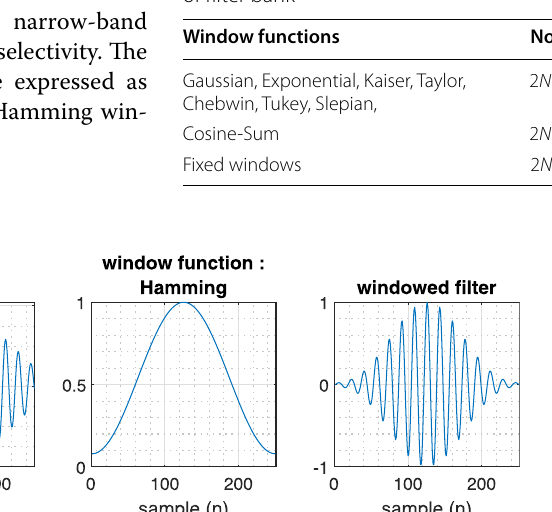
Table 1 Trainable parameters of Sinc filters, where N is the